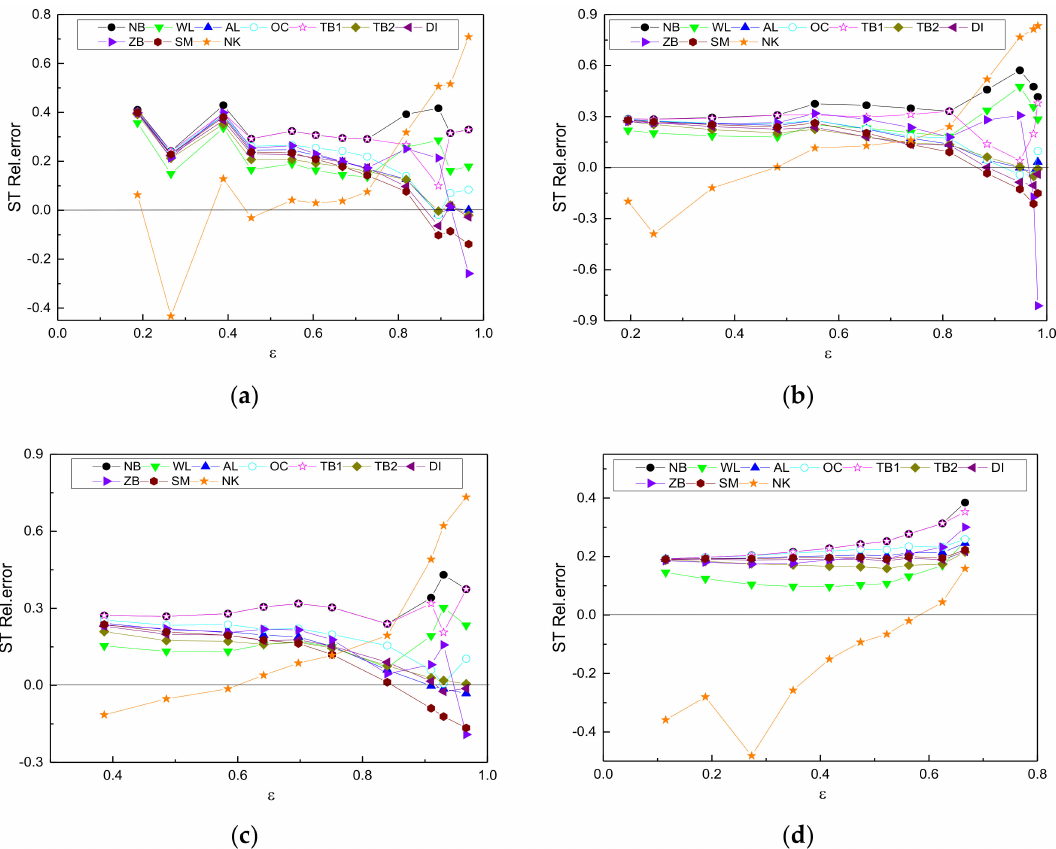
Figure 6. Comparison of relative errors in estimating fatigue life by frequency-domain method (steel): ( a ) Single peak spectrum; ( b ) bmodal spectrum; ( c ) multi-peak spectrum; ( d ) band-limited white noise spectrum.